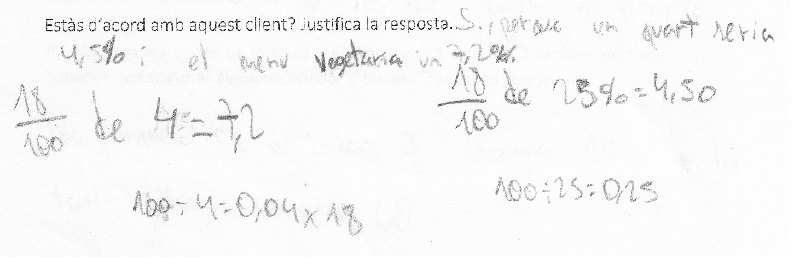
Figure 13. Incorrect answer of Q5 (translation: yes, because a quarter would be 4.5% and vegetarian menu, 7.2%).